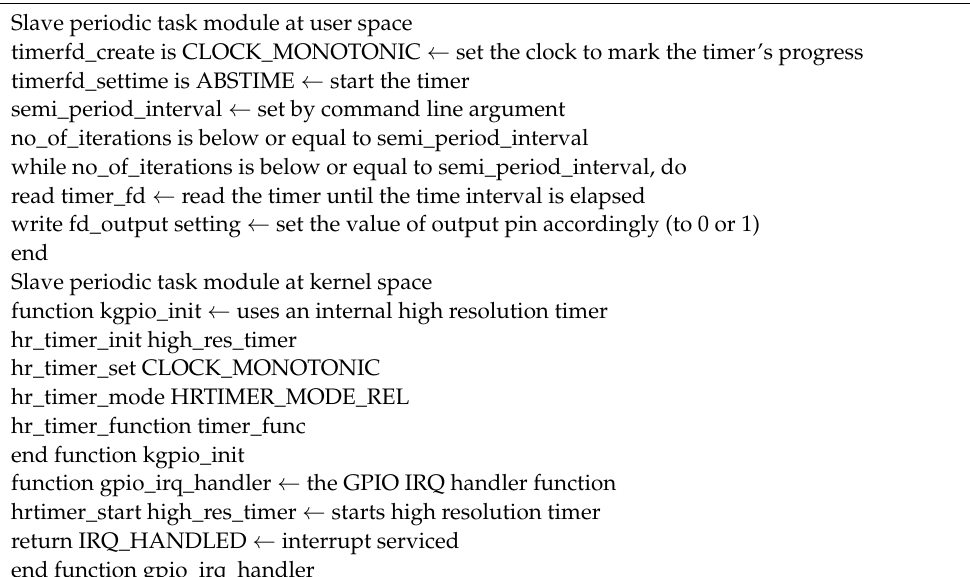
Algorithm A2 User and kernel space periodic task measurement